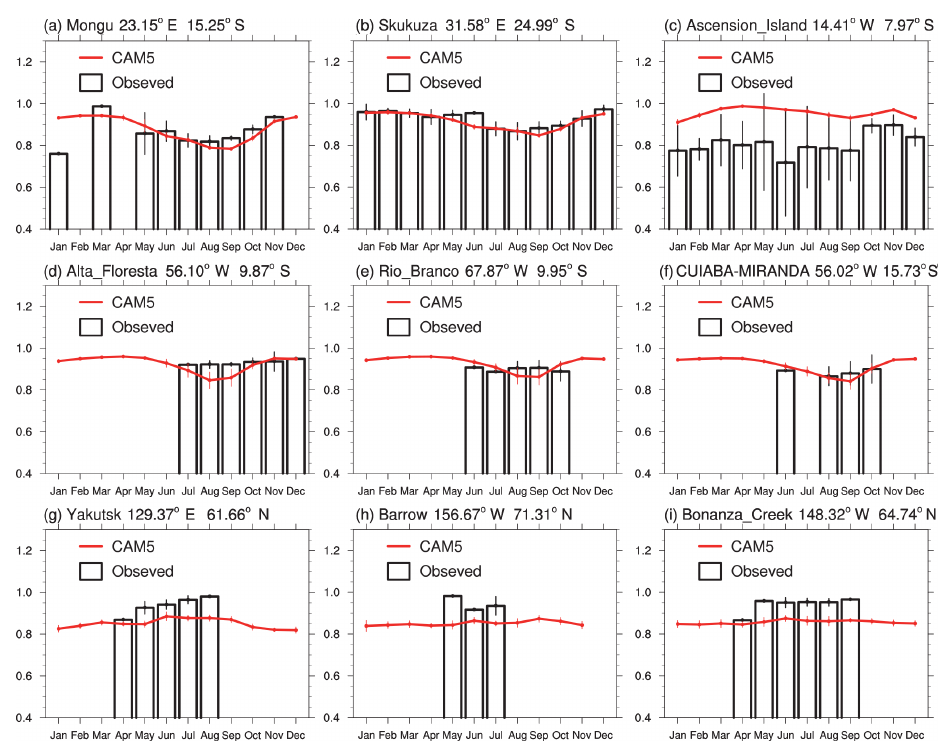
Figure 3. Same as Fig. 2, but for the comparison of single-scattering albedo (SSA) at